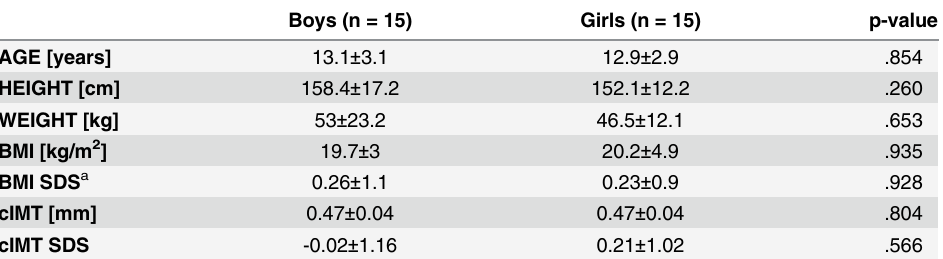
Table 2. Anthropometric data and cIMT values of study participants in mean ±